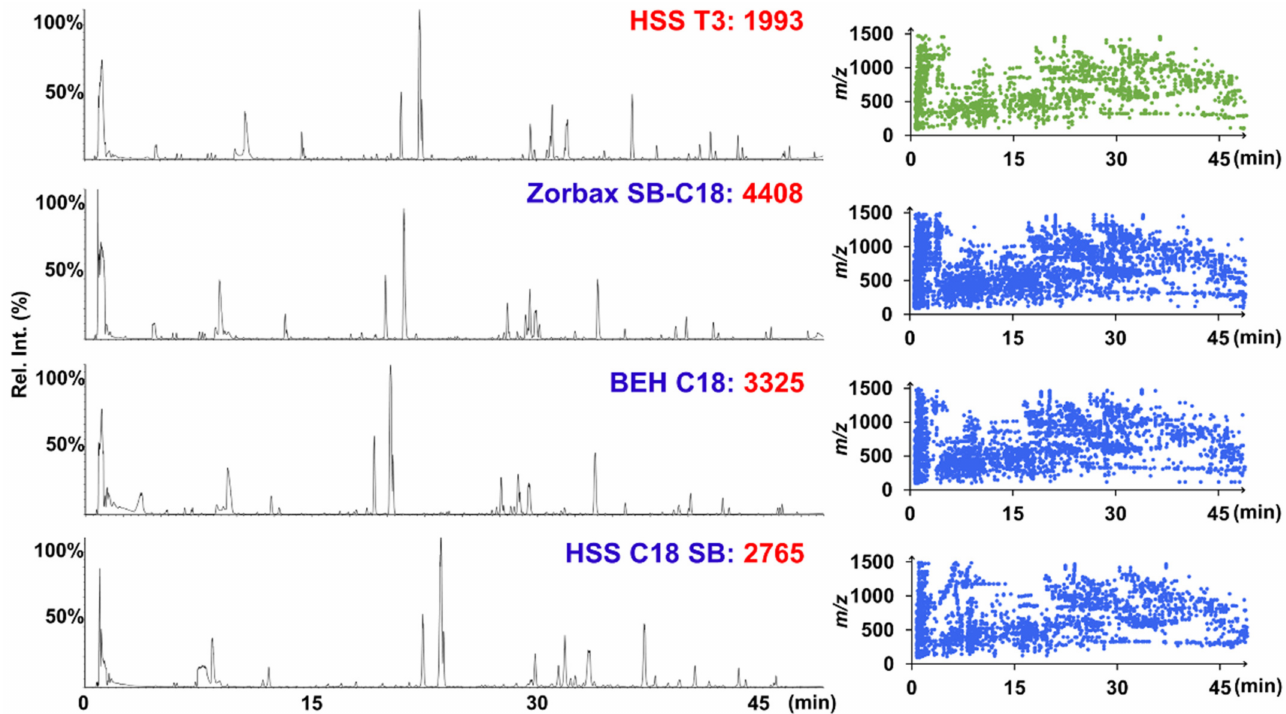
Figure 3. The representative UHPLC columns (including HSS T3, Zorbax SB-C18, BEH C18, and HSS C18 SB) used for the stationary-phase screening. The left shows the base peak intensity (BPI) chromatograms obtained on the candidate columns, while the right shows a scatter plot of the components resolved by both MS and chromatographic